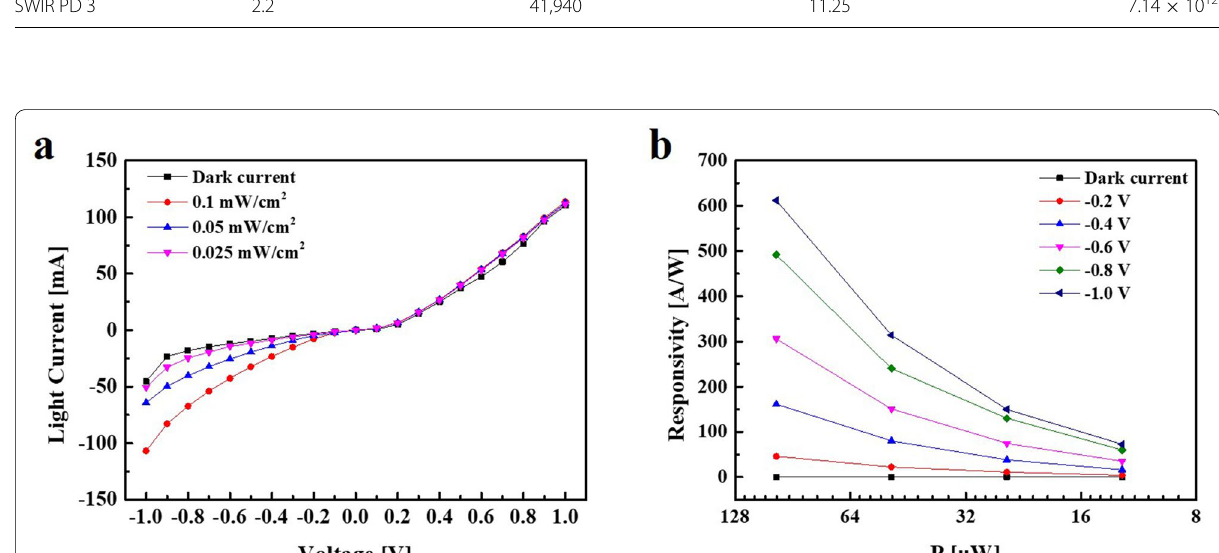
Table 1 Performance of fabricated SWIR photodetector under IR light, 0.1 mW/cm2 at a bias of Device